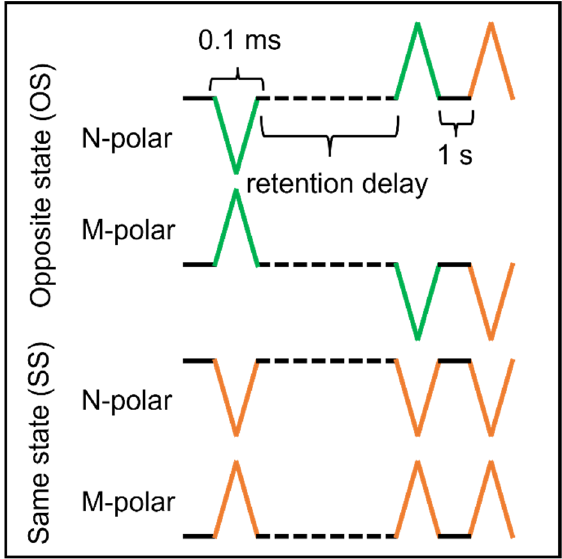
Figure 1. Retention test protocols for OS and SS in either a nitrogen or metal polar surface state. Green and orange traces represent switching and non − switching pulses, respectively.